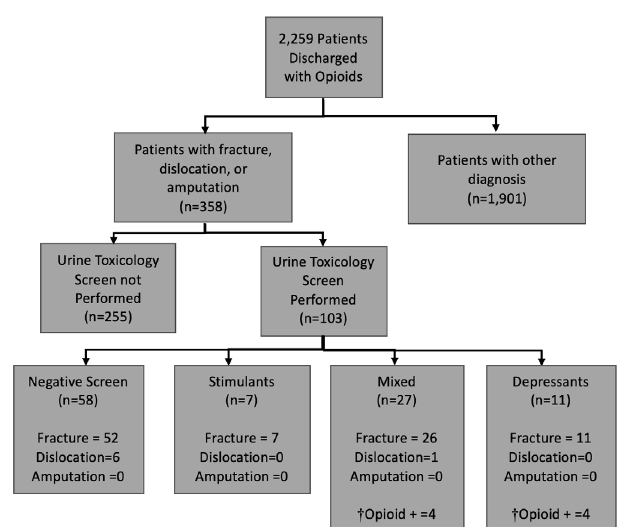
Figure 1. Study enrollment and exclusion November 2017– October